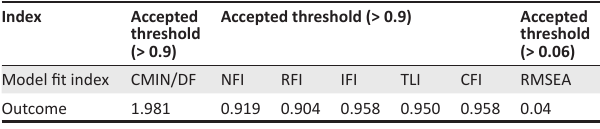
TABLE 4: Model fit